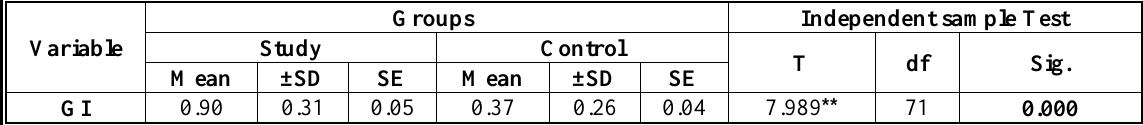
Table 3: The Gingival index difference among the study and control groups.